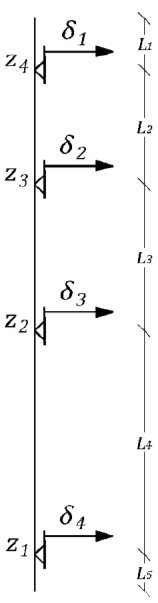
Figure 7. Third test: structural identification.